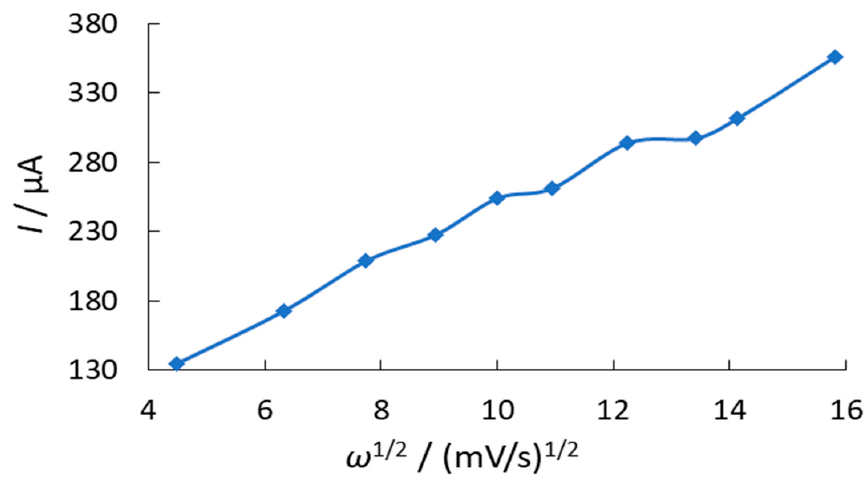
Figure 4. Dependence of the O 2 electroreduction current on the RPE on the potential scan rate to the power of ½ in the presence of 0.1% phenothiazine in 85% ethanol solution.